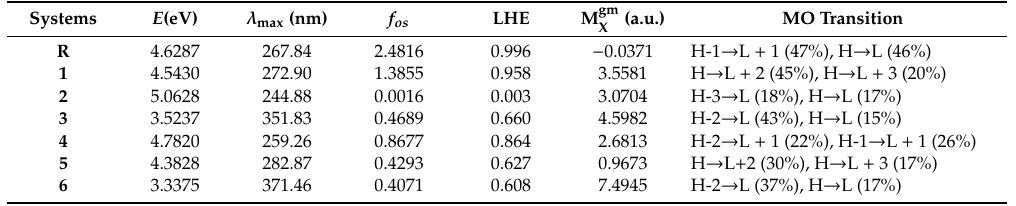
Table 8. Computed transition energy (eV), wavelengths ( λ ), oscillator strengths ( f os ), light